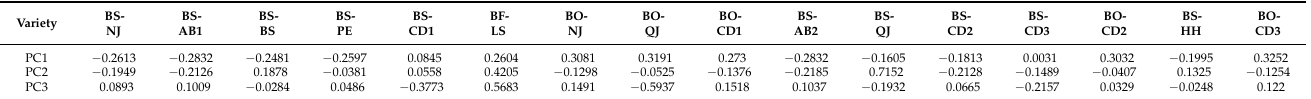
Table 3. Cluster correspondence of